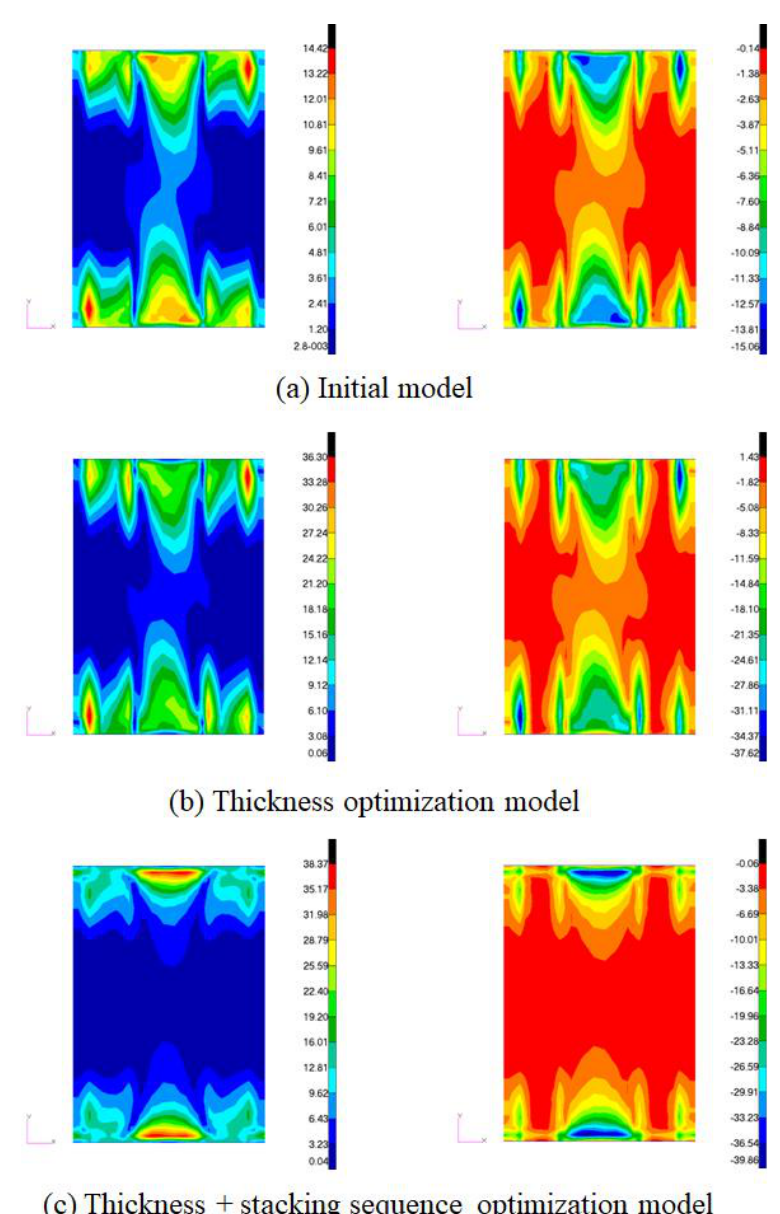
Figure 17. Comparison of stress σ xy results (left: tension, right: compression).